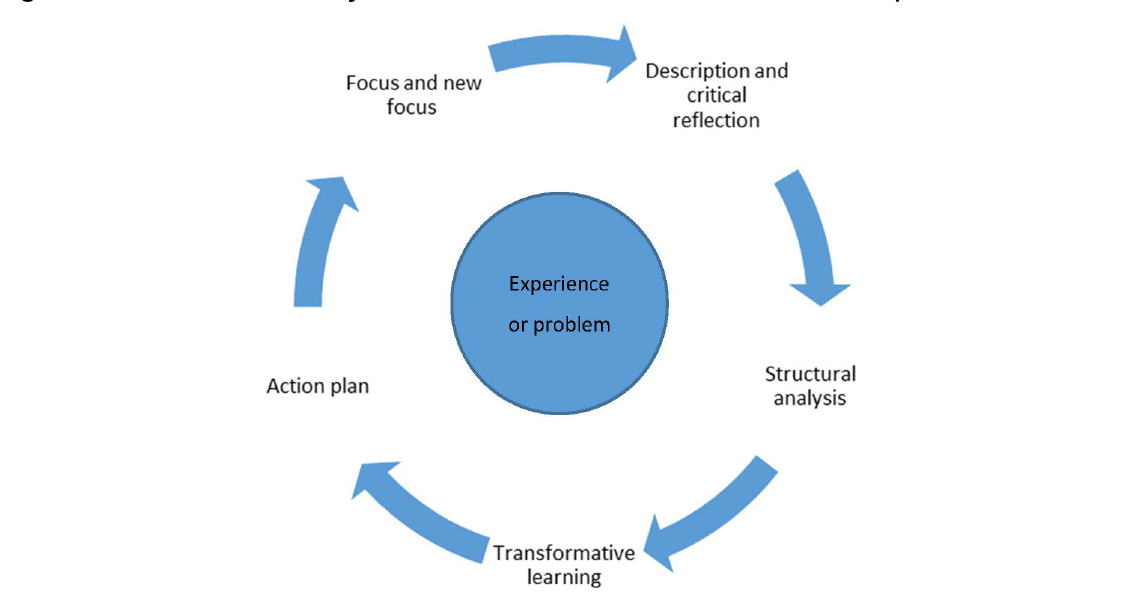
Figure 1. Critical didactic analysis model (Source: Tireli and Jacobsen, 2019, p.